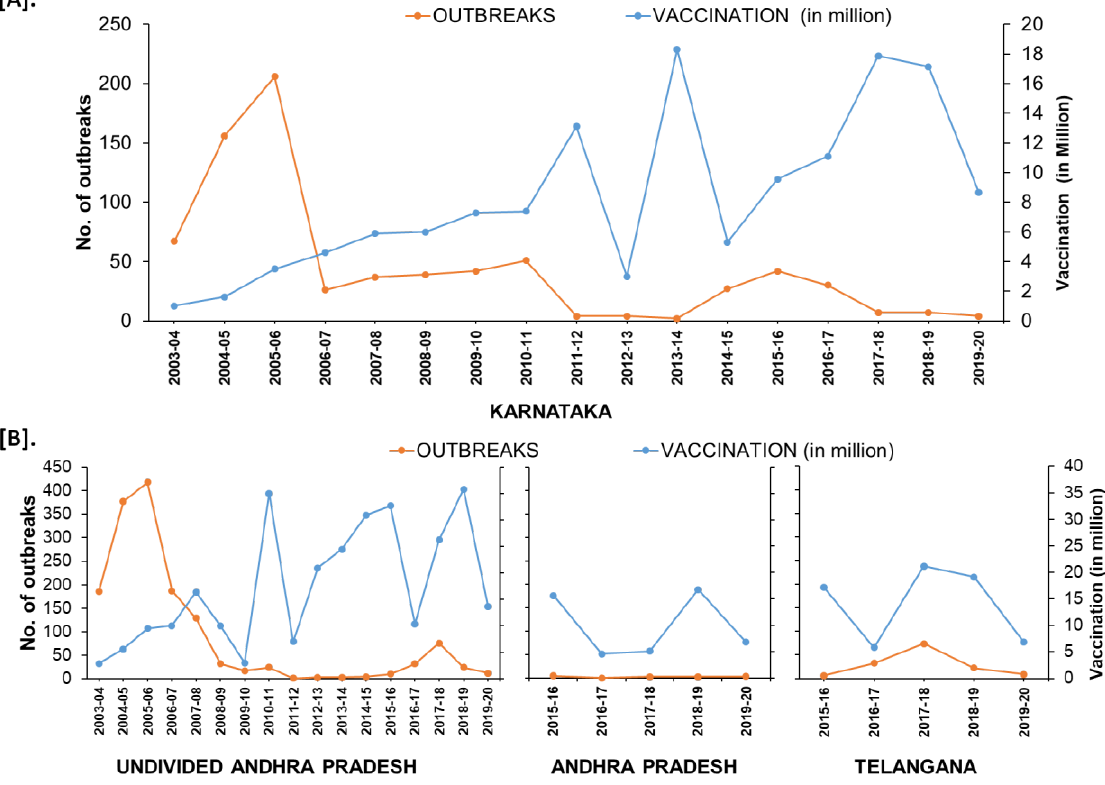
Figure 11. The trend of reduction of outbreaks in the states of Karnataka ( A ) Andhra Pradesh ( B ) from the financial year 2003–2004 to 2019–2020; outbreak reports versus the doses of vaccines used (in million) in the strategic immunizations during the preceding years are depicted as the vaccine produces immunity for 3–6 years.